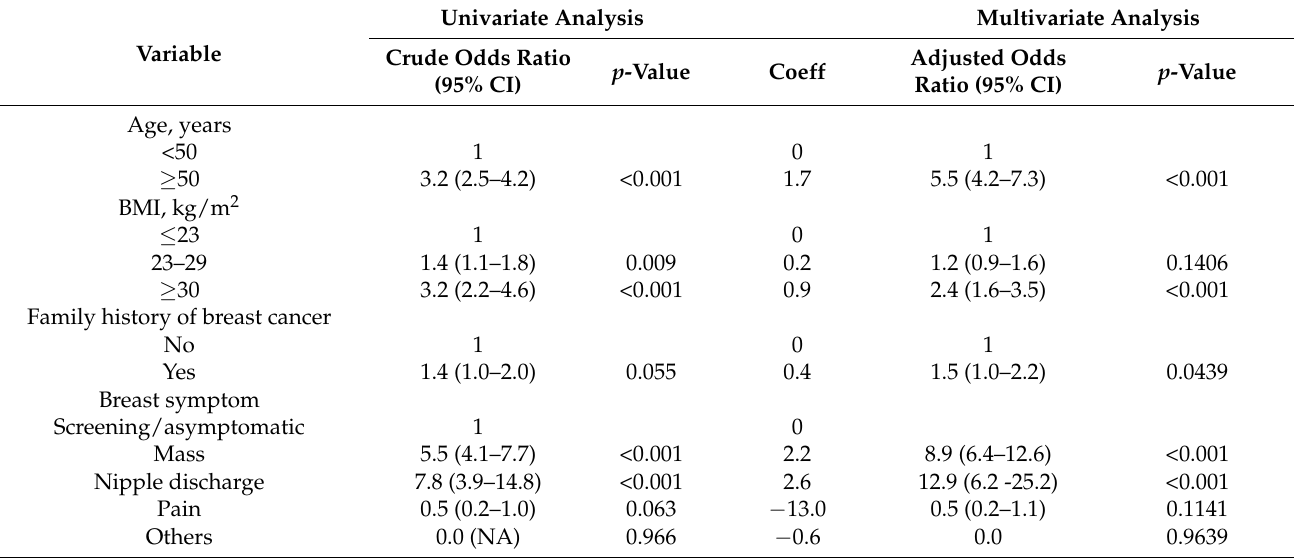
Table 3. Univariable and multivariable logistic regression for breast cancer